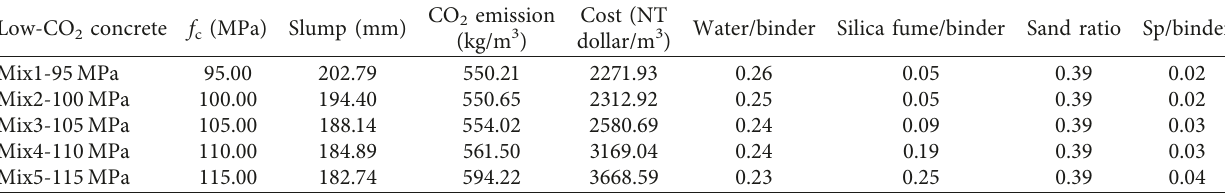
Table 5: Performance of low-CO